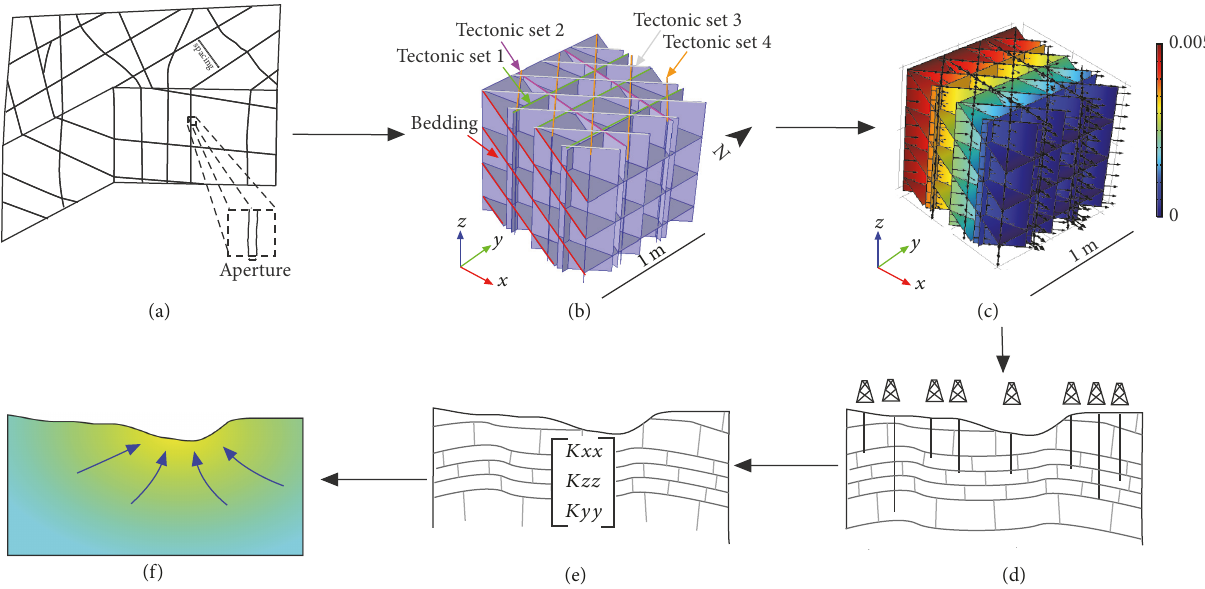
Figure3:Flowdiagramfortheproposedmethodology.Geomechanicalanalysisincludingtheevaluationoforientation,spacing,andaperture (a) allows constructing discrete-fractured cubes (b) representing the average fracturing condition. Numerical models at 1m scale (c) have been calibrated via pumping tests (d) estimating the hydraulic conductivity tensor at regional scale (e). The latter has been tested via numerical simulation at regional scale and compared with conceptual models from literature